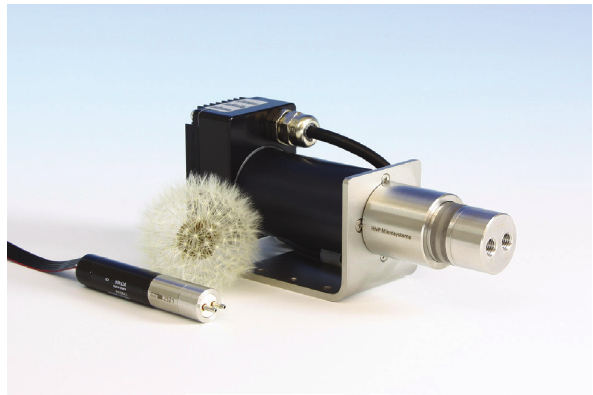
Figure 3 mzr-pumps permit a multitude of applications.